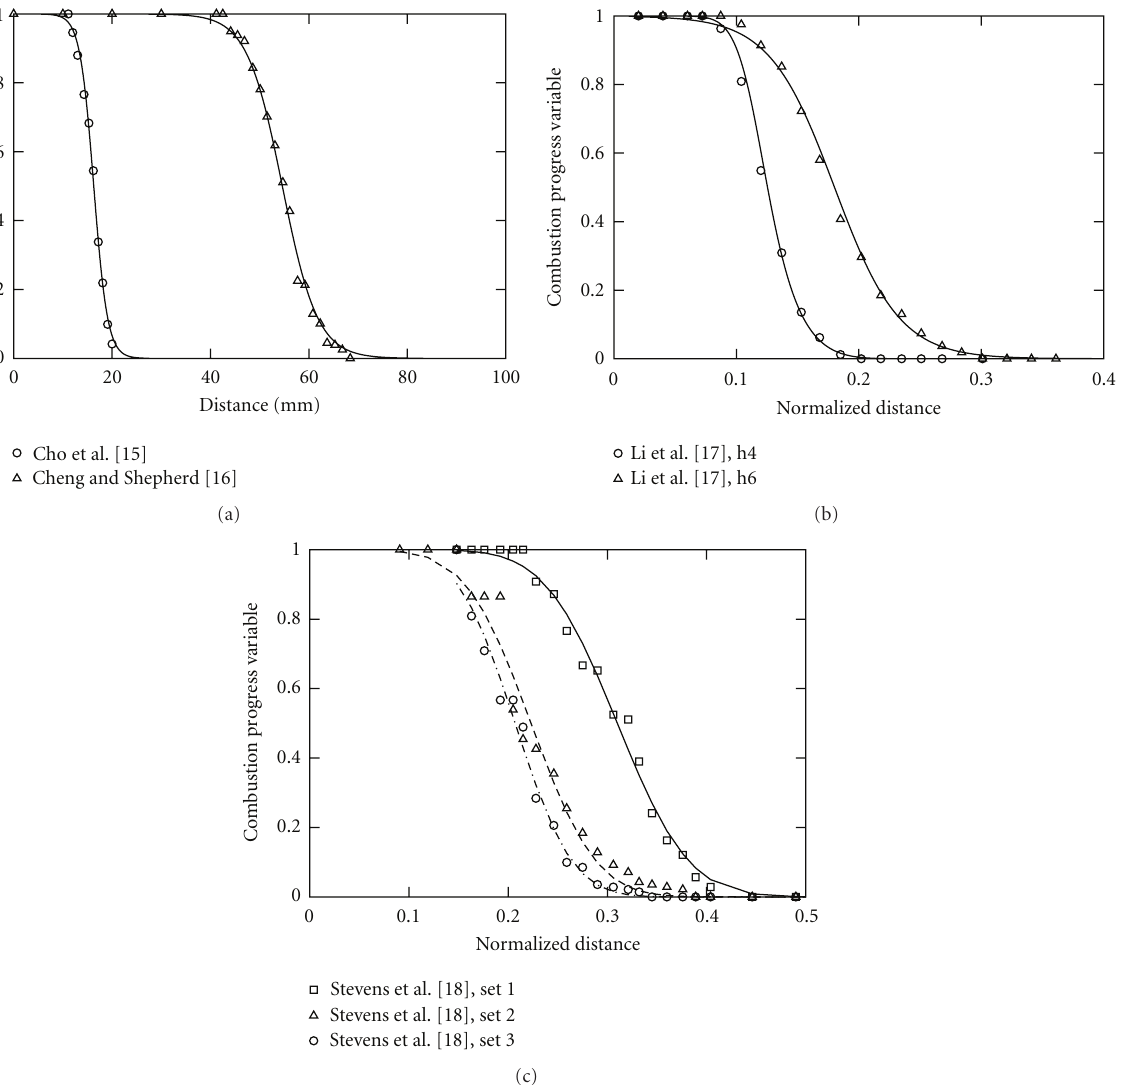
Figure 2: Axial profiles of (a) the Reynolds-averaged combustion progress variable c ( x ), measured by Cho et al. [15] and by Cheng and Shepherd [16], and the Favre-averaged combustion progress variable (cid:6) c ( z ), measured (b) by Li et al. [17] and (c) by Stevens et al. [18]. Symbols show experimental data. Curves have been obtained using